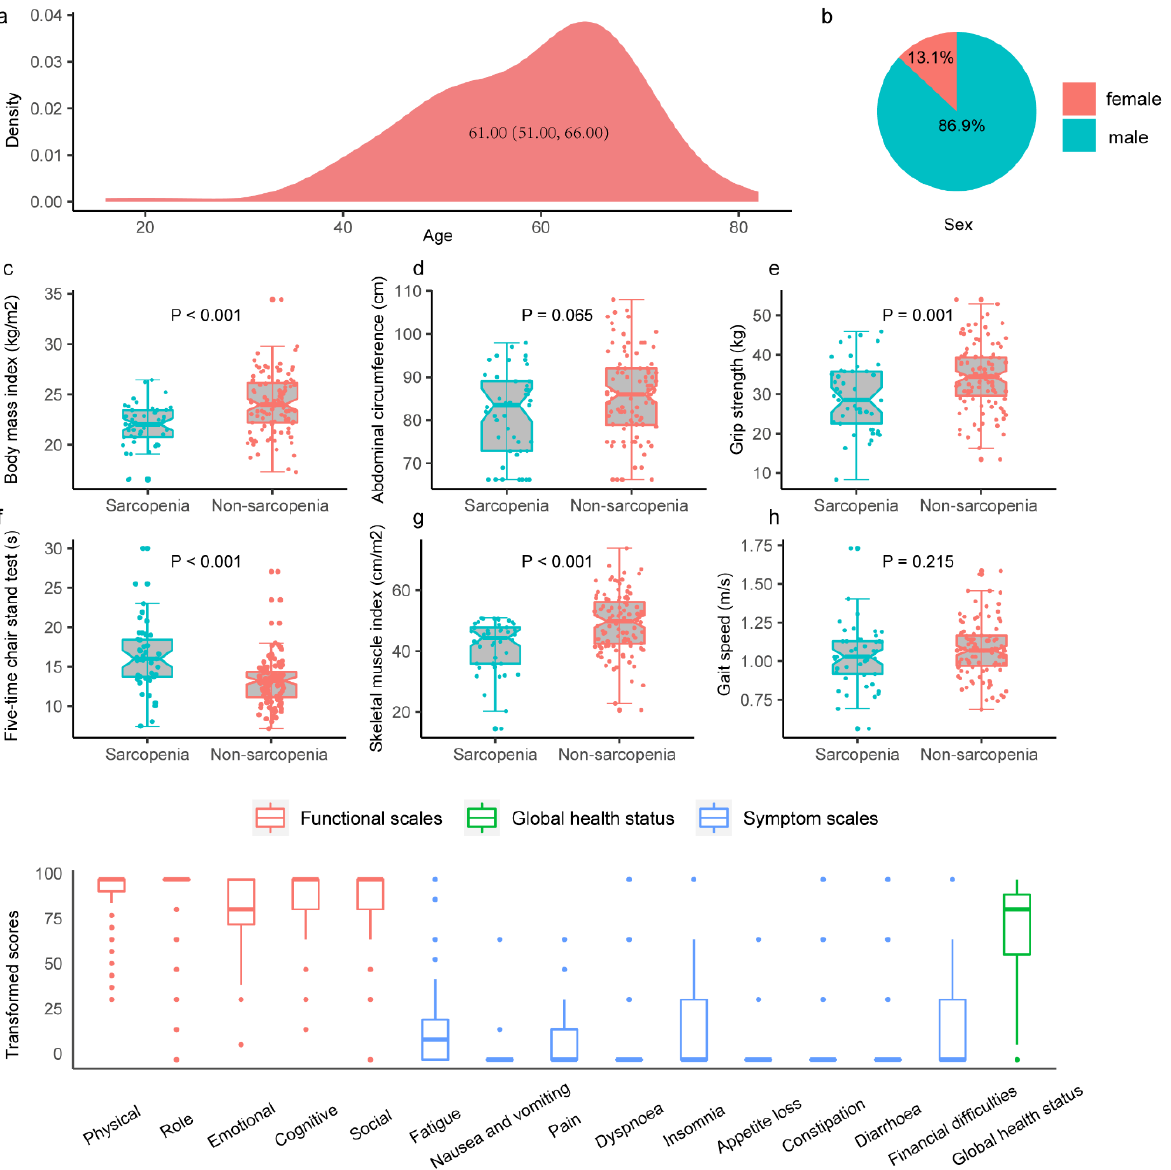
Figure 2. Informational description of the study cohort. Cohort age distribution ( a ) and sex distribution ( b ). ( c – h ) Description and comparison of sarcopenia-related indicators in people with and without sarcopenia: Body mass index ( c ), Abdominal circumference ( d ), Grip strength test ( e ), Five-time chair stand test ( f ), Skeletal muscle index ( g ), Gait speed ( h ). ( i ) Display of QLQ-C30 questionnaire data.